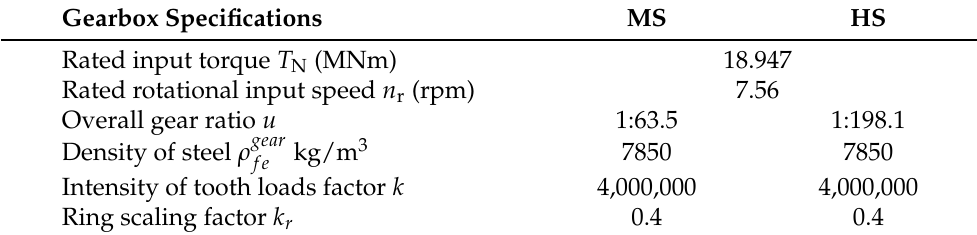
Table 3. Gearbox Specifications.